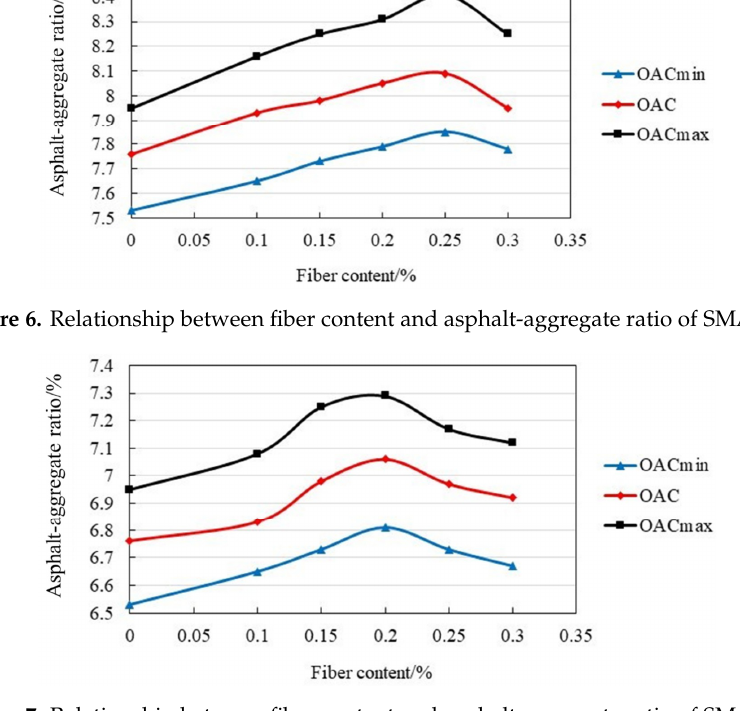
Figure 7. Relationship between fiber content and asphalt-aggregate ratio of SMA- Ⅱ -3.